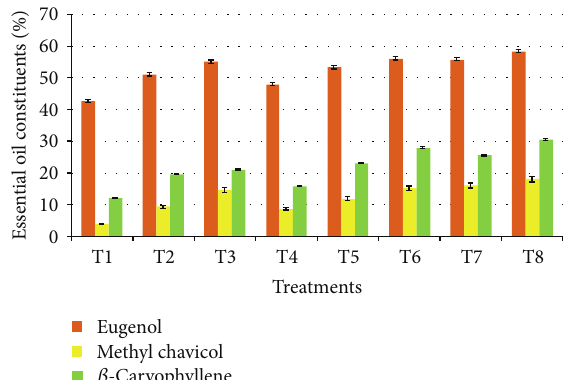
Figure2:Themajoressentialoilconstituentsinfluencedbydifferent microbial treatments in Ocimum tenuiflorum cv.